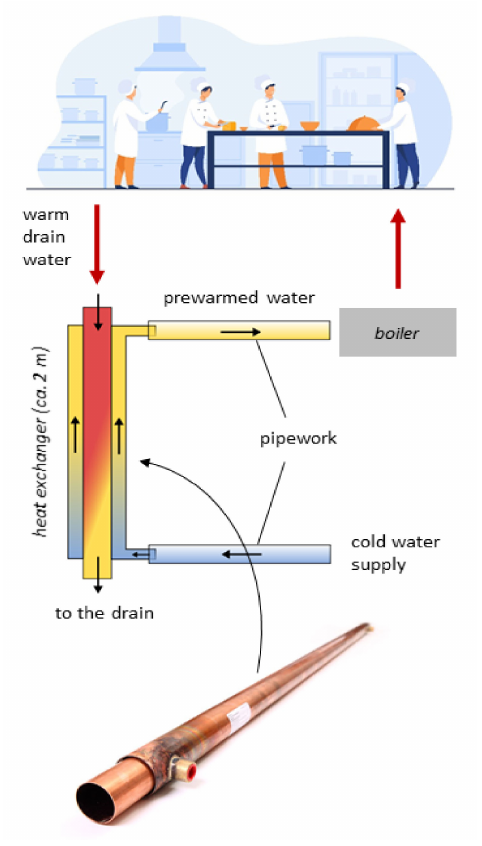
Figure 1. Overview of heat recovery from kitchen drain water with a pipe-in-pipe heat exchanger. With graphical elements modified from